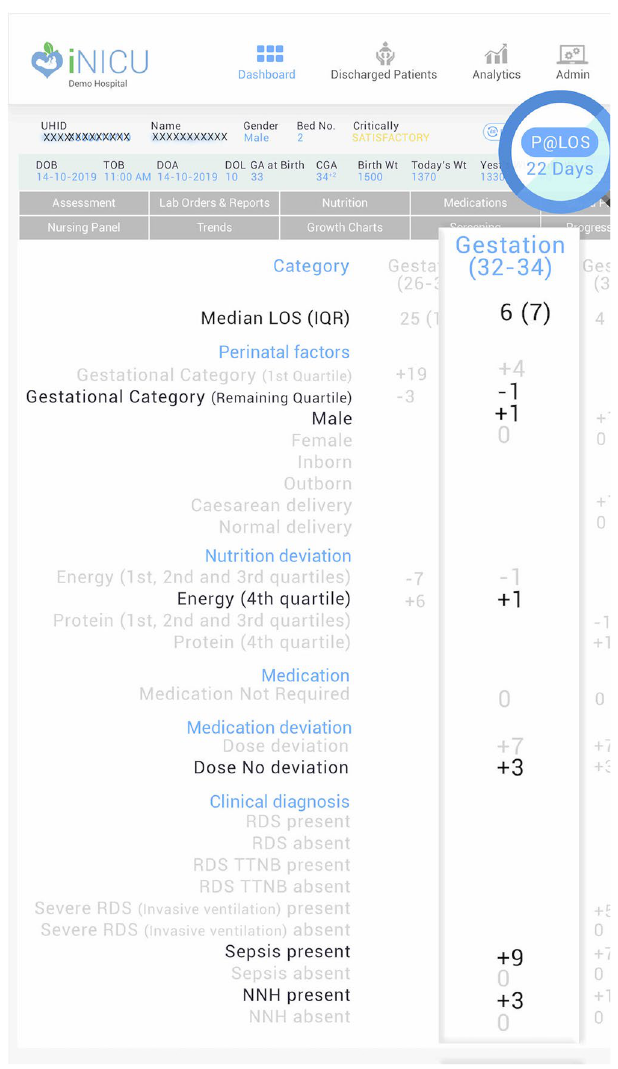
Figure 5. Bedside LOS prediction model displayed on iNICU interface, values marked in black represents the value applicable for the